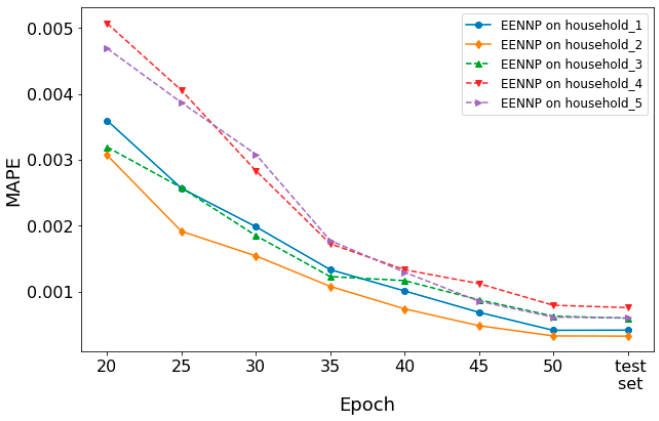
Figure 8. Performance of EENNP on different households.